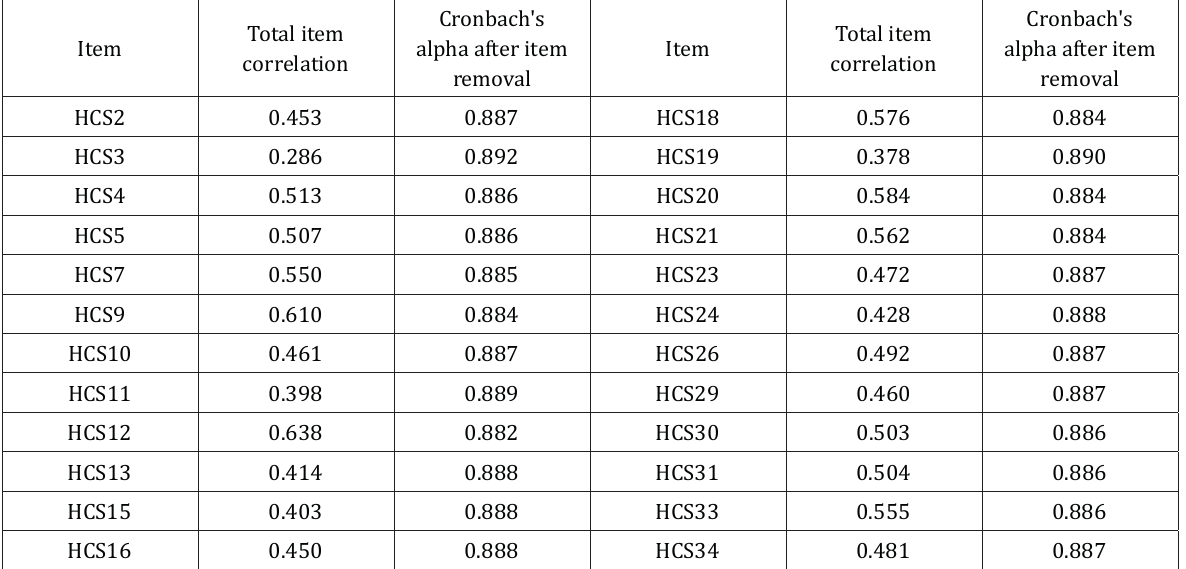
Table 3. Reliability of the HCS item